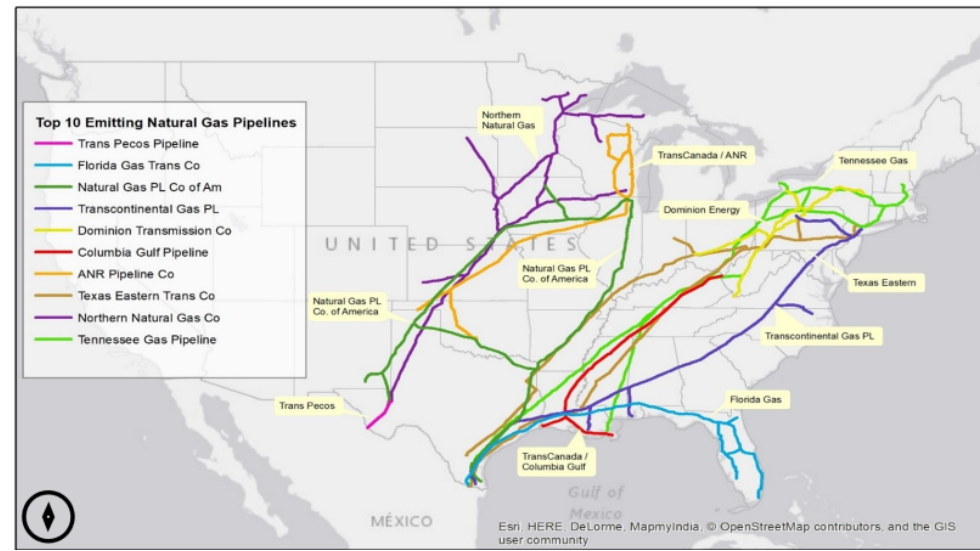
Figure 20. Map of Top 10 CO 2 Emission Bottlenecks- Natural Gas Pipelines in the United States (Generating using OpenStreetMap).